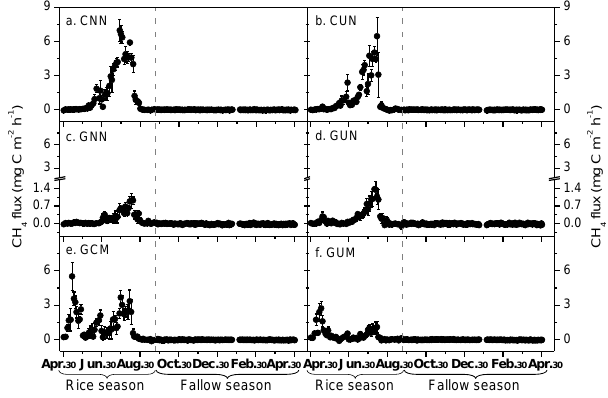
Figure 3. Seasonal dynamics in (a–f) methane (CH 4 ) fluxes (mean ± standard error) for different fertilizer treatments in the conven- tional paddy and ground cover rice production systems during the rice–fallow rotation cycle of 2011–2012. The CH 4 fluxes during the rice season as shown in panels (c–f) were measured from the raised beds of ground cover rice production systems. Definitions of ab- breviations for the different fertilizer treatments are shown in the footnotes of Table 1 and in the text.